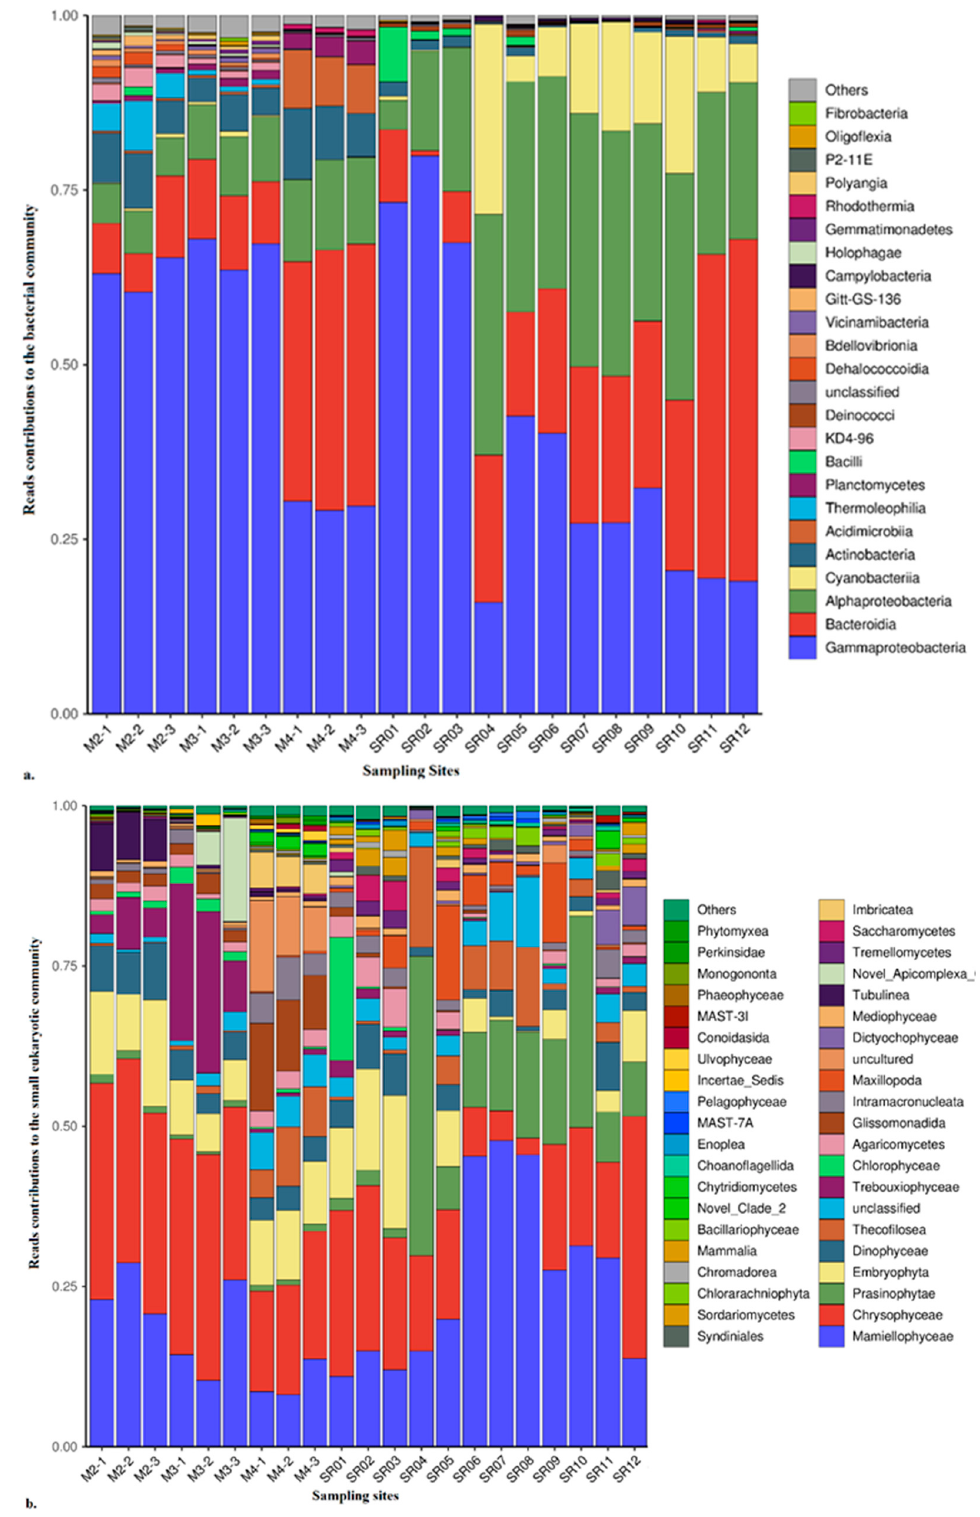
Figure 4. Reads of contributions to the bacterial library of different classes at different sites in Ny-Ålesund. M2–M4 indicate soil sites with their respective triplicates; SR01–SR12 indicate different sites of glacial melts: ( a ) for bacterial community, ( b ) for eukaryotes < 20 μ m.